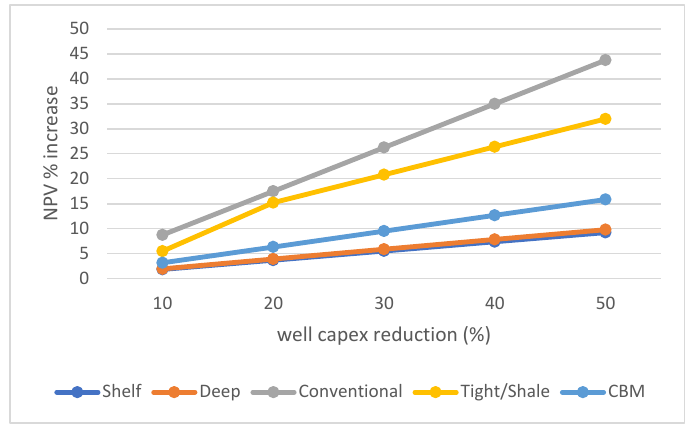
Figure 9. Increase in NPV as a function of well capex reduction. Energies 2018 , 11 , x FOR PEER REVIEW